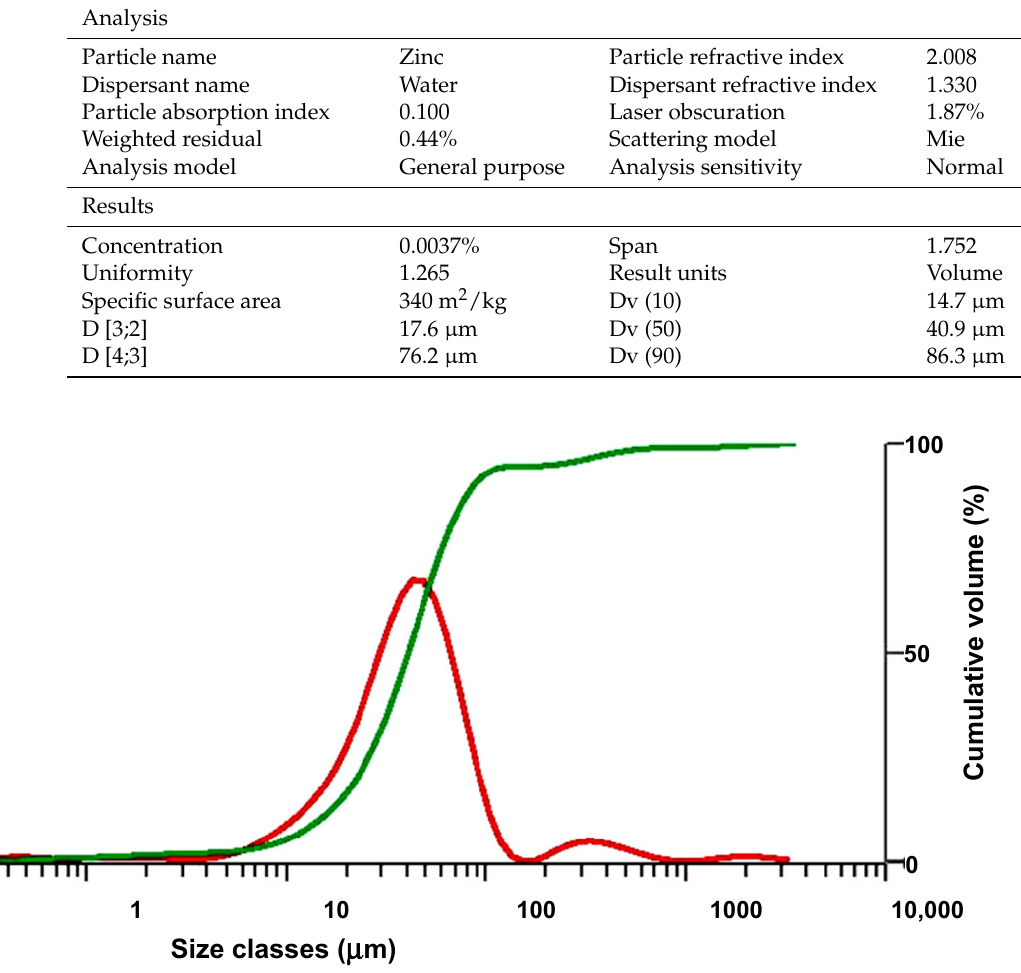
Table 20. Condition at the laser diffraction analysis of Zn powder.